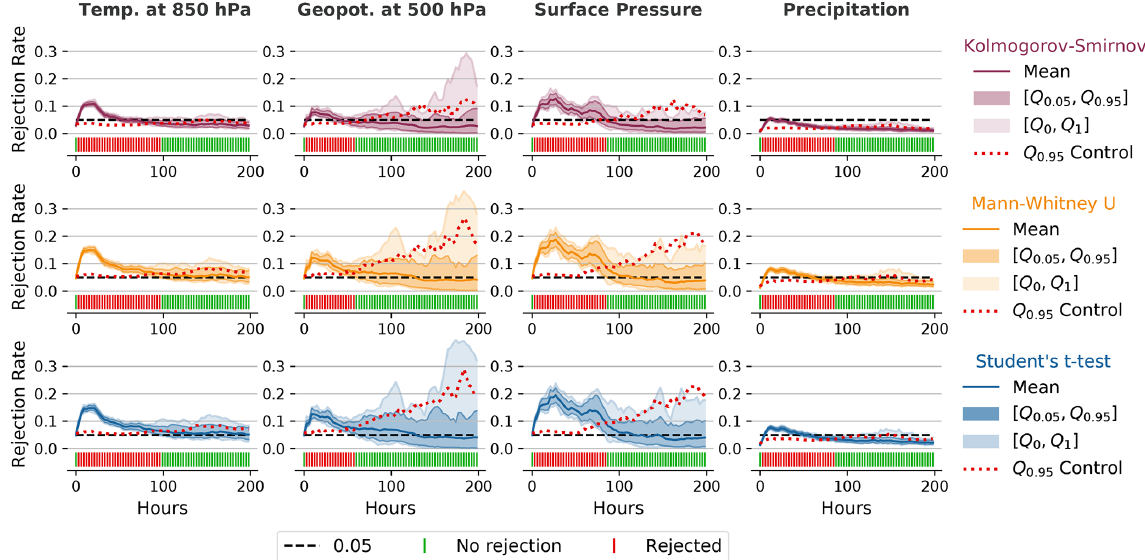
Figure 5. Rejection rates and decisions similar to Fig. 3 for different variables and with the use of different underlying statistical hypothesis tests for the diffusion ensemble with D = 0 . 01 and n E = 50, n S = 20, and m = 100. While the rejection rates show some differences, the global decisions are very similar throughout all tests for the corresponding variables. The rejection rates with the K-S test are usually lower than those for the other two tests, but this does not affect the global decisions, as the respective 0.95 quantiles from the control ensemble are also lower. Student’s t test shows very similar rejection rates to the nonparametric MWU test, even for precipitation, which is clearly not normally